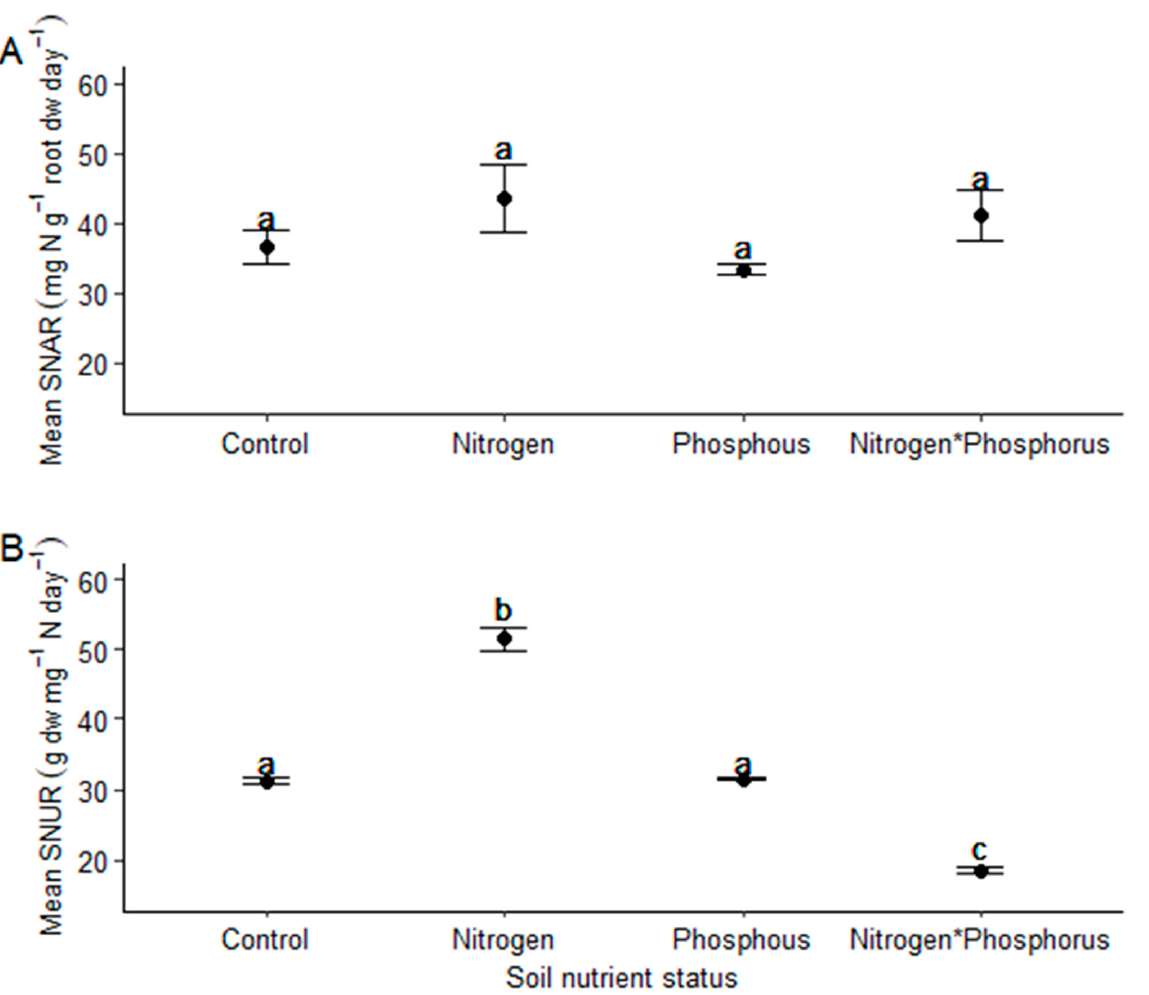
Figure 5. The mean ± standard error ( A ) specific N absorption rate (mg Ng − 1 root dw day − 1 ) and ( B ) specific N use rates (g dw mg − 1 N day − 1 ) of V. sieberiana saplings grown in soils with various nutri ‐ tional statuses: control (no nutrients); nitrogen (limestone ammonium nitrate); phosphorus and both